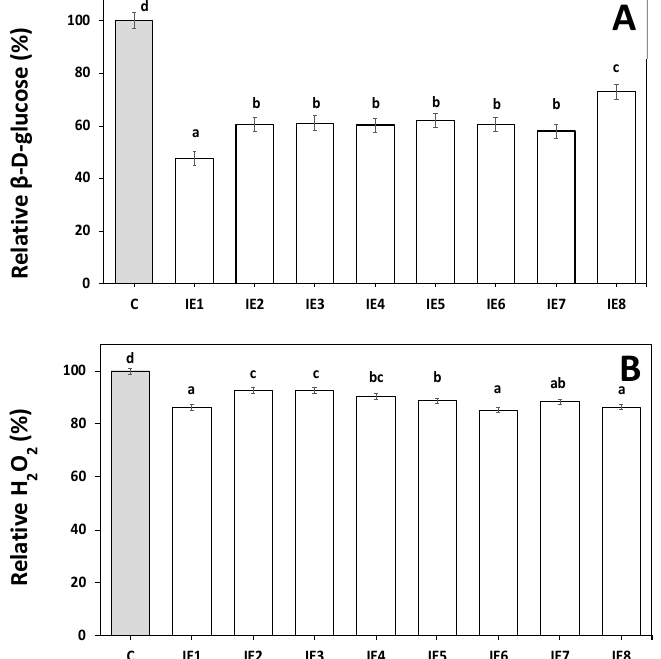
Figure 5. Operational stability of co-immobilized GOX ( A ) and CAT ( B ) capsules at 25 °C in 8 con- secutive cycles of 90 min and 2 min, respectively. C: Control without enzymes; IEn: Immobilized enzymes (n = cycle number). Bars with di ff erent le tt ers are signi fi cantly di ff erent at p ≤ 0.05.